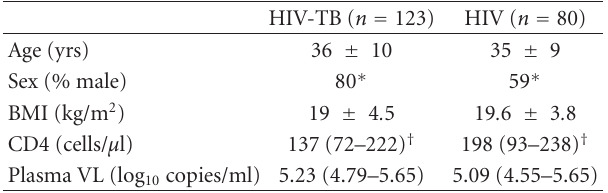
Table 1: Baseline characteristics of 203 patients with HIV/AIDS. Table 2: Detailed description of 123 TB patients in the HIV-TB